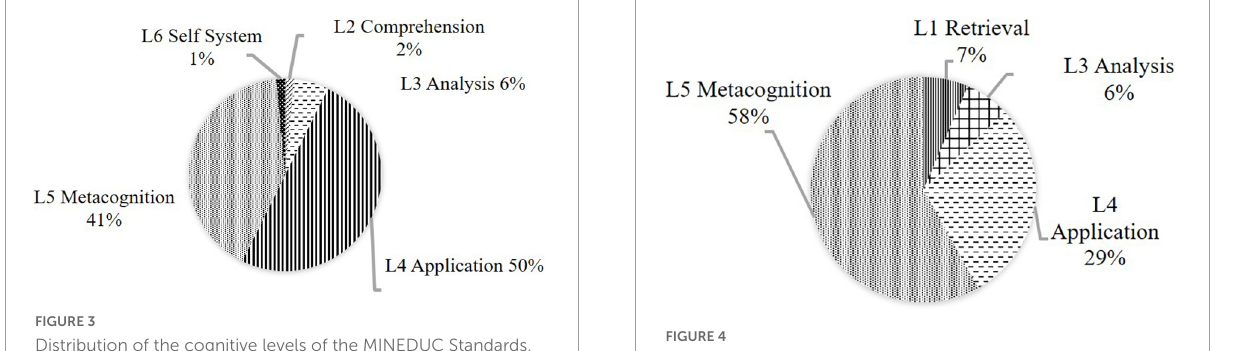
Distribution of the cognitive levels of the UNESCO